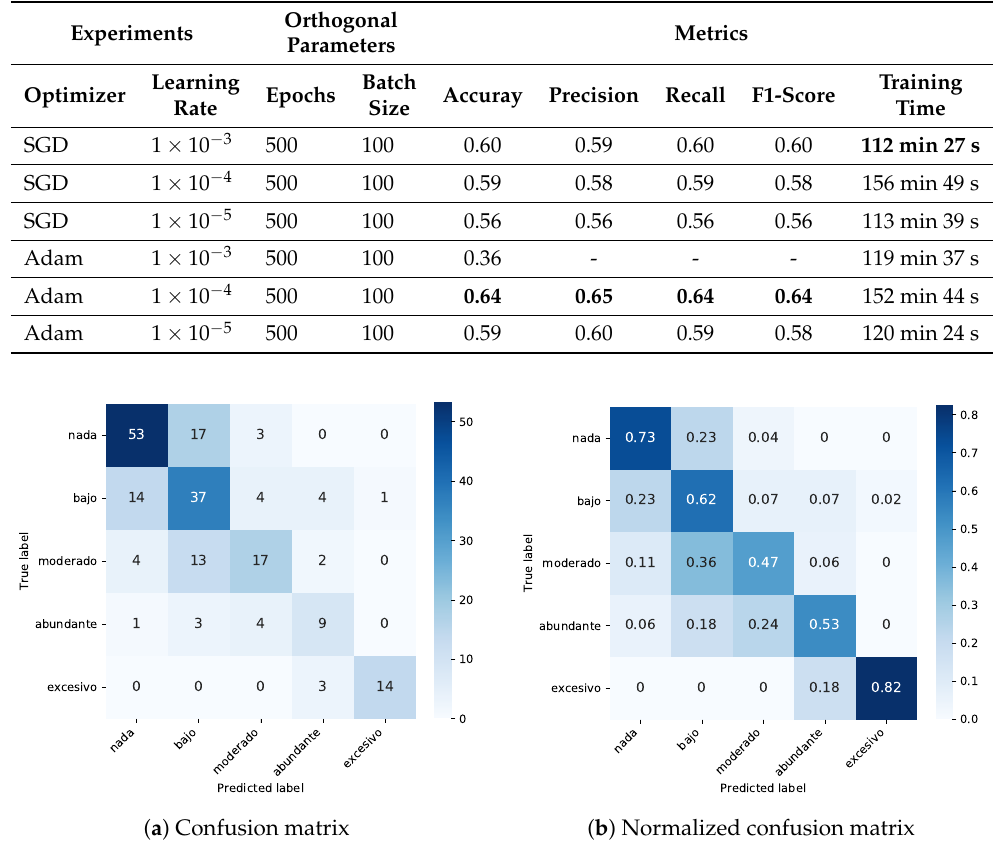
Figure 3. Single and normalized confusion matrices for the classification of Sargassum. Translated labels are: nada (nothing), bajo (low), moderado (fair), abundante (plenty), and excesivo (excessive).